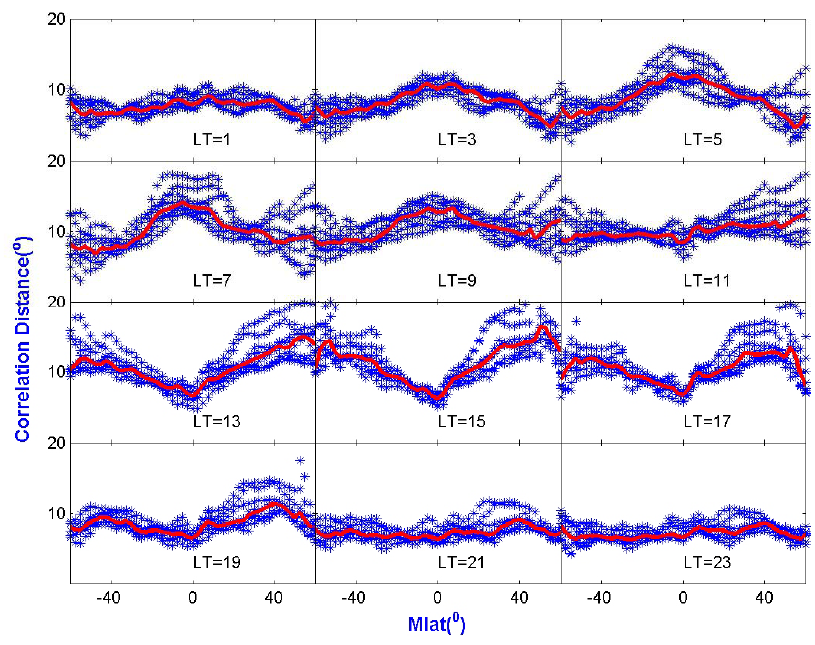
Figure 3a. Latitude variations of meridional correlation distance for the 12 selected local times. Solid Fig. 3. (a) Latitude variations of meridional correlation distance for the 12selected local times. Solid lines are the corresponding mean lines are the corresponding mean values of different seasons during 2000 and 2005. values of different seasons during 2000 and